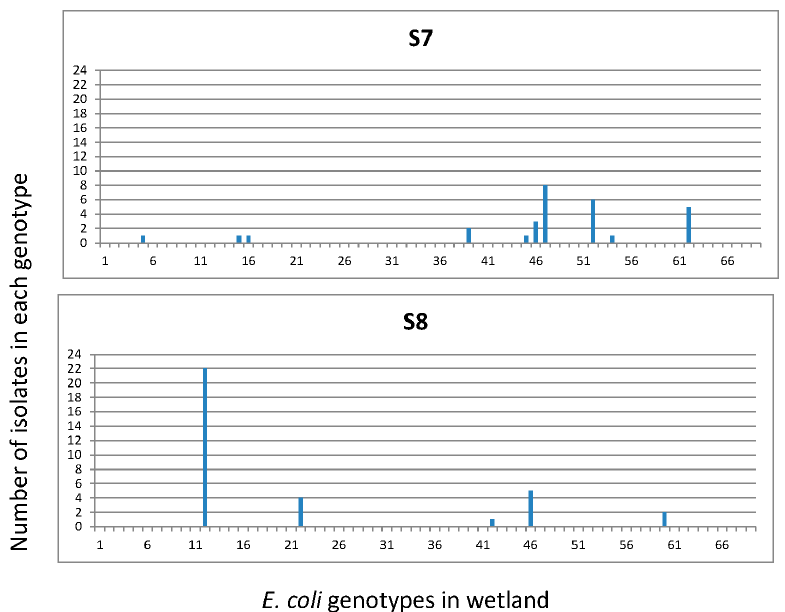
Figure 5. E. coli genotypes based on REP PCR distributions. Symbols on the X -axis are effluent from swine house (S1), two-stage anaerobic lagoon system consisting of a primary lagoon 1 (S2) with overflow into a secondary lagoon 2 (S3) that flows to the storage tank (S4), continuous wetland cell influent (S5), continuous wetland cell effluent (S6), storage pond (S7), final effluent samples (S8) where it was recycled for flushing of the swine production facility and for land application.